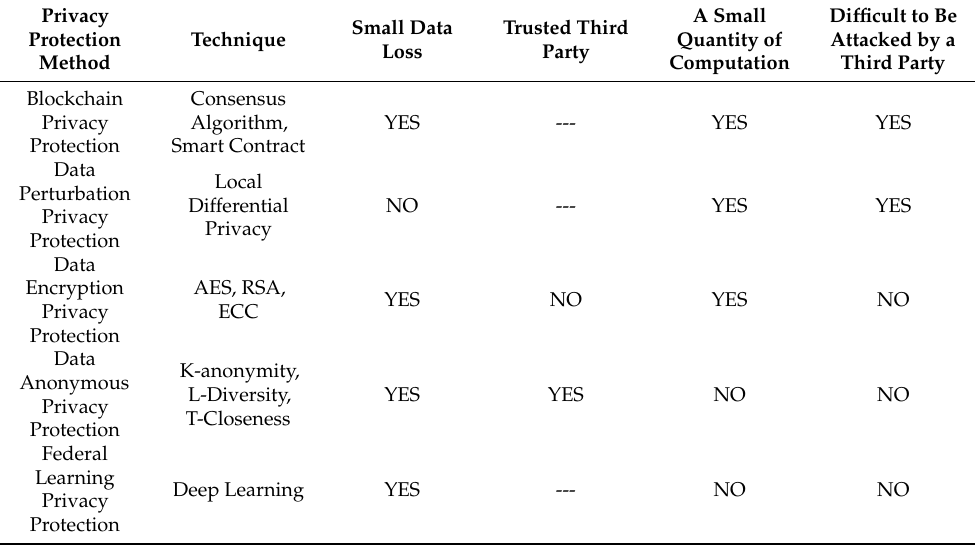
Table 4. Comparison of blockchain technology with other data privacy protection